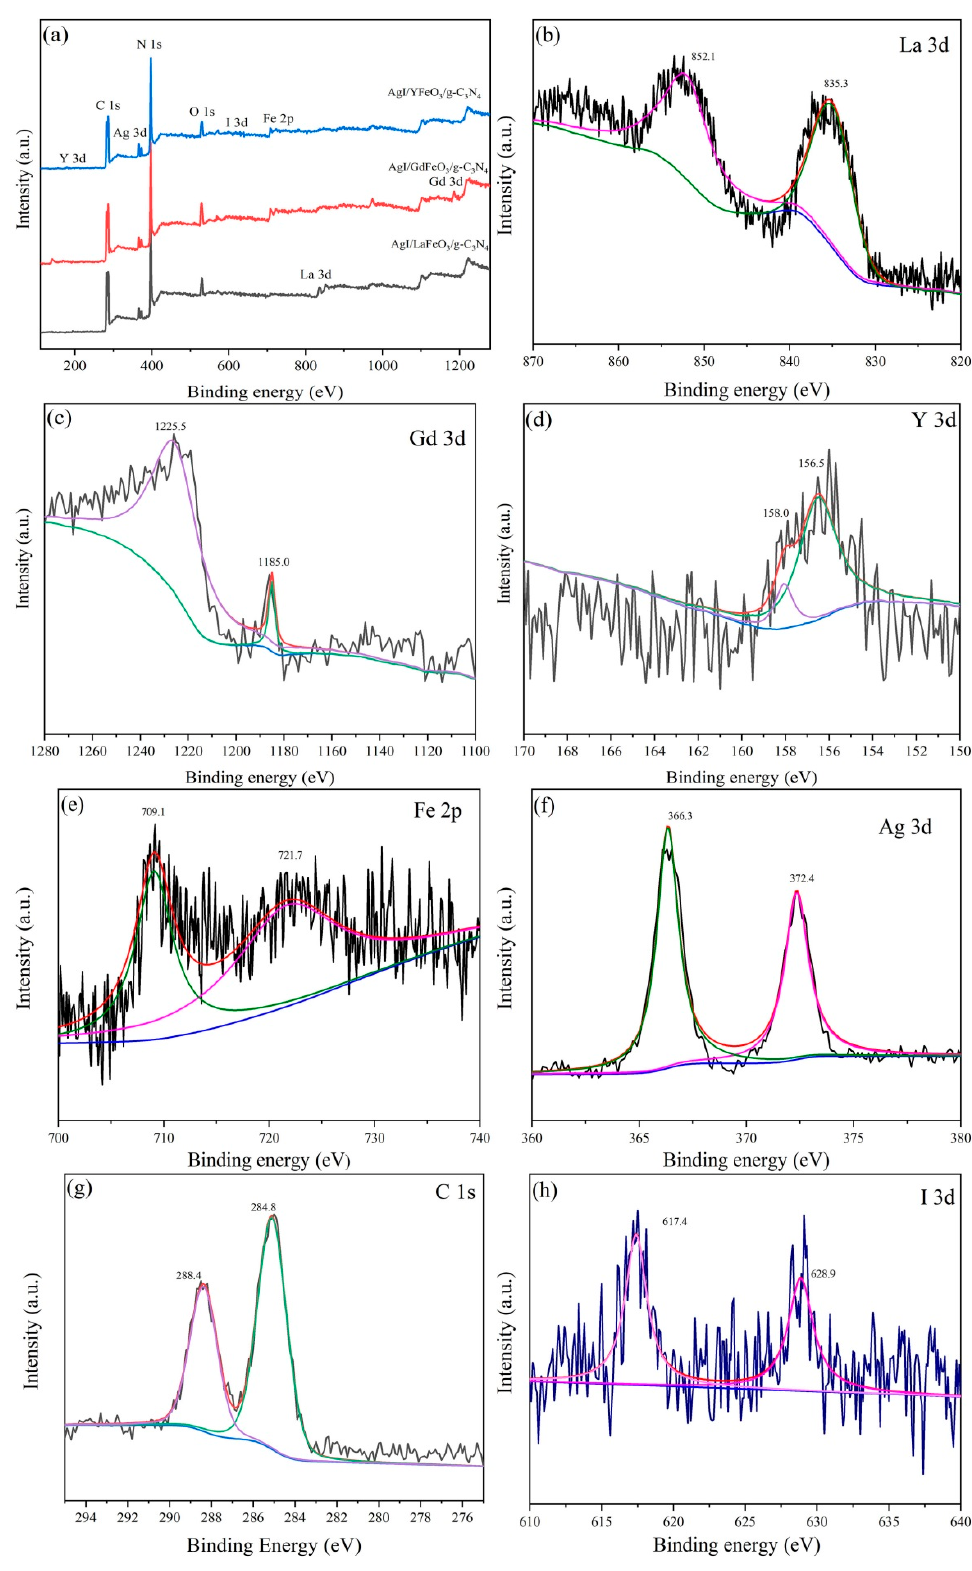
Figure 3. ( a ) X-ray photoelectron spectra of full spectra, ( b ) La 3d, ( c ) Gd 3d, ( d ) Y 3d, ( e ) Fe 2p, ( f ) Ag 3d, ( g ) C 1s, and ( h ) I 3d. ( f ) Ag 3d, ( g ) C 1s, and ( h ) I